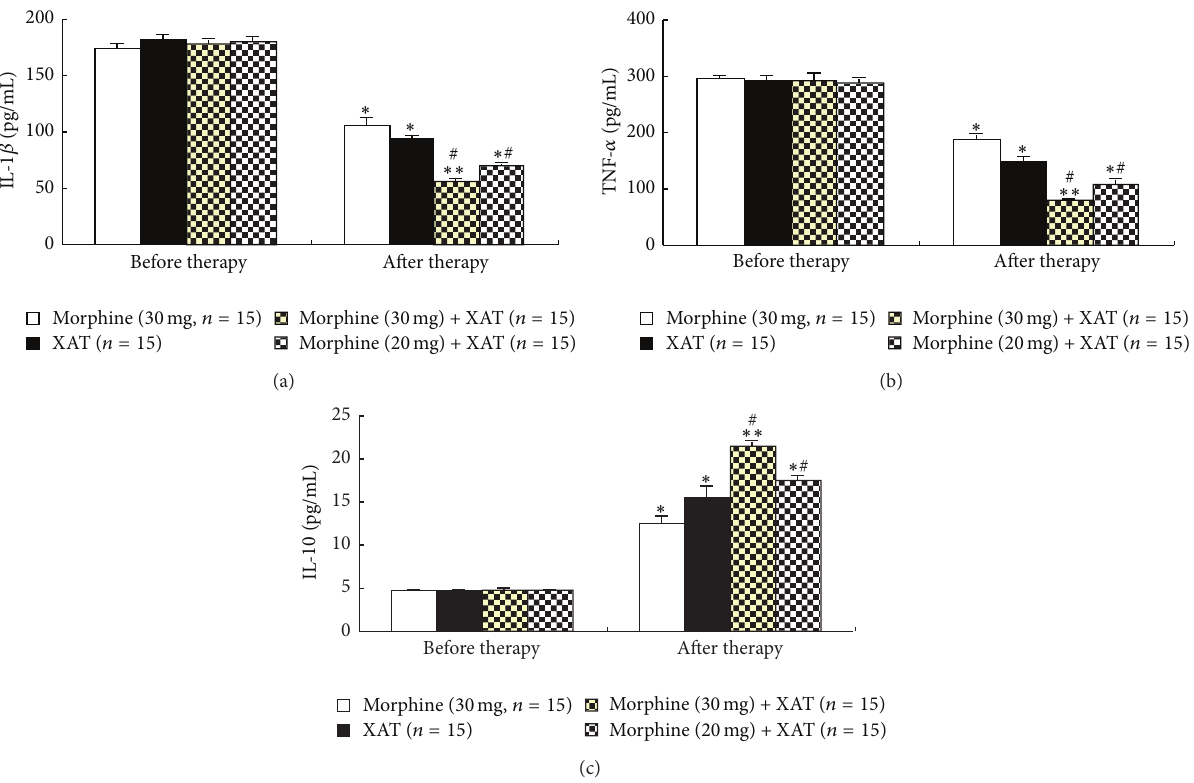
Figure 3: Effects of repetitive oral administration of XAT, morphine, and their combinations on the blood cytokines IL-1 𝛽 , TNF- 𝛼 , and IL-10. ELISA was used to measure these cytokines in blood from the cancer pain patients. Number of patients in each group is indicated in the parentheses and all of these patients were the same patients included in Figure 1(a) and they received the same treatments in the same protocols in the corresponding groups. The blood samples were collected on day 7, that is, 1 day after termination of the last treatment. One- way ANOVA. ∗ 𝑃 < 0.05 and ∗∗ 𝑃 < 0.01 versus the same group before therapy. # 𝑃 < 0.05 versus morphine after therapy in the corresponding